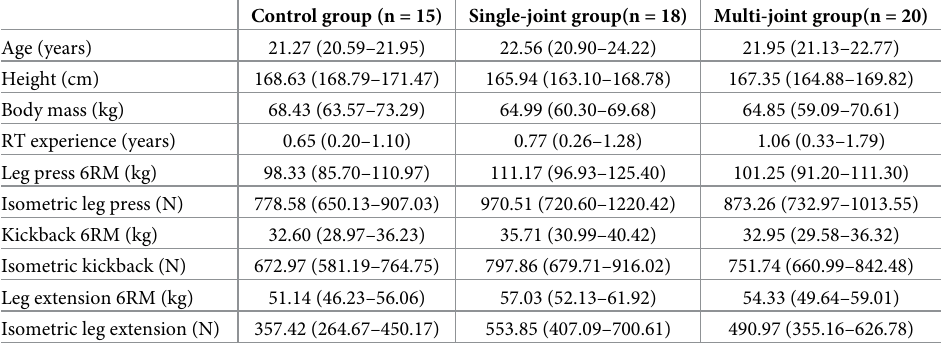
Table 1. Physical characteristics, resistance training (RT) experience, six repetitions maximum (6RM) and iso- metric force (N) at baseline. Control group (n =